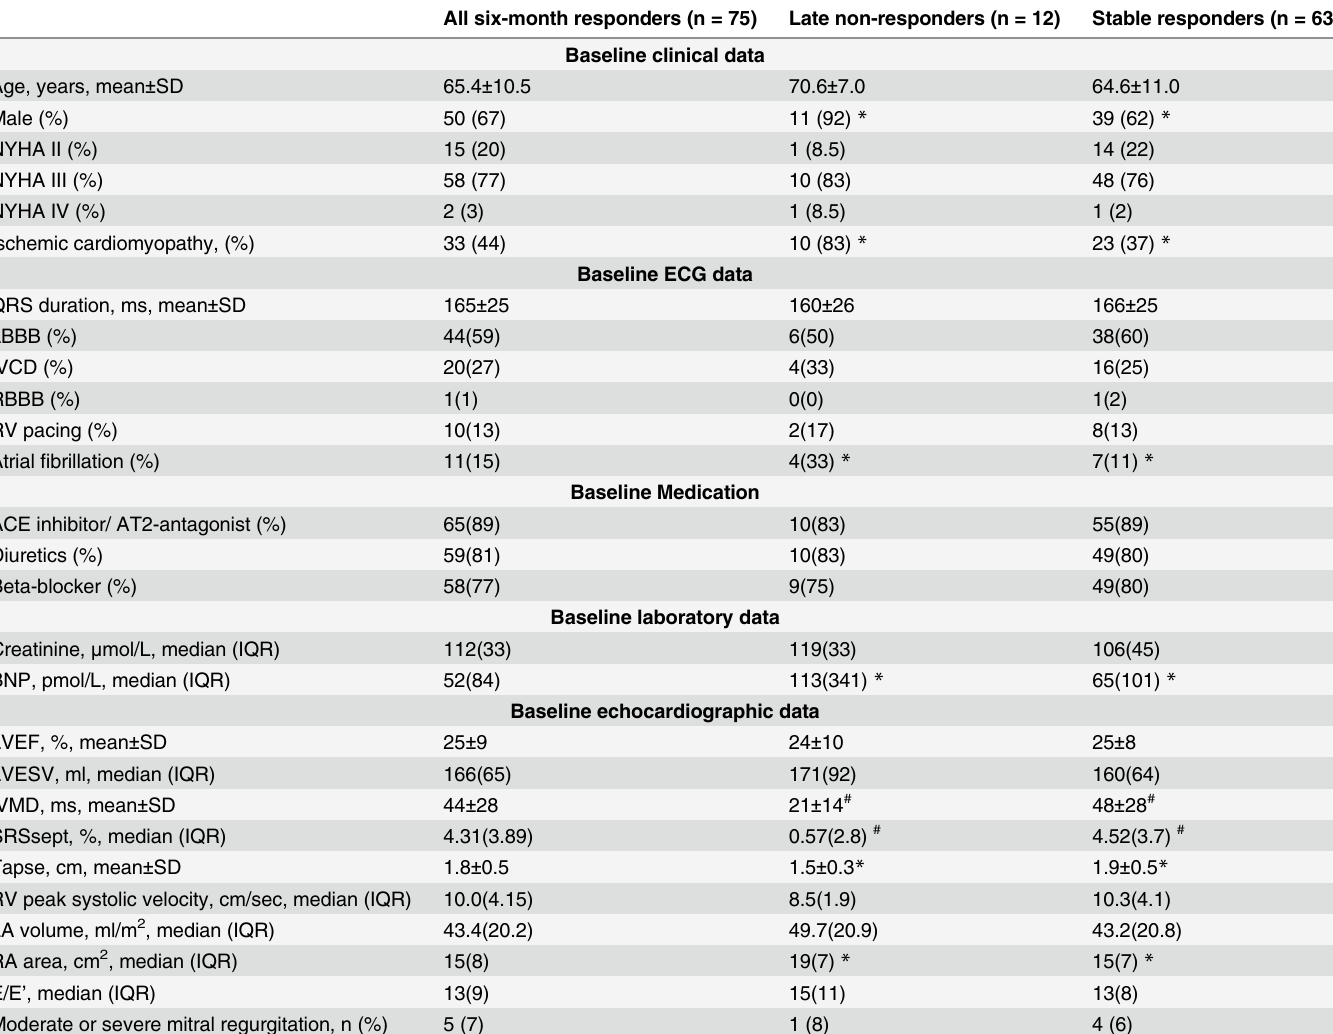
Table 1. Baseline data of six-month responders, and stratified by late non-responders and stable responders. All six-month responders (n =